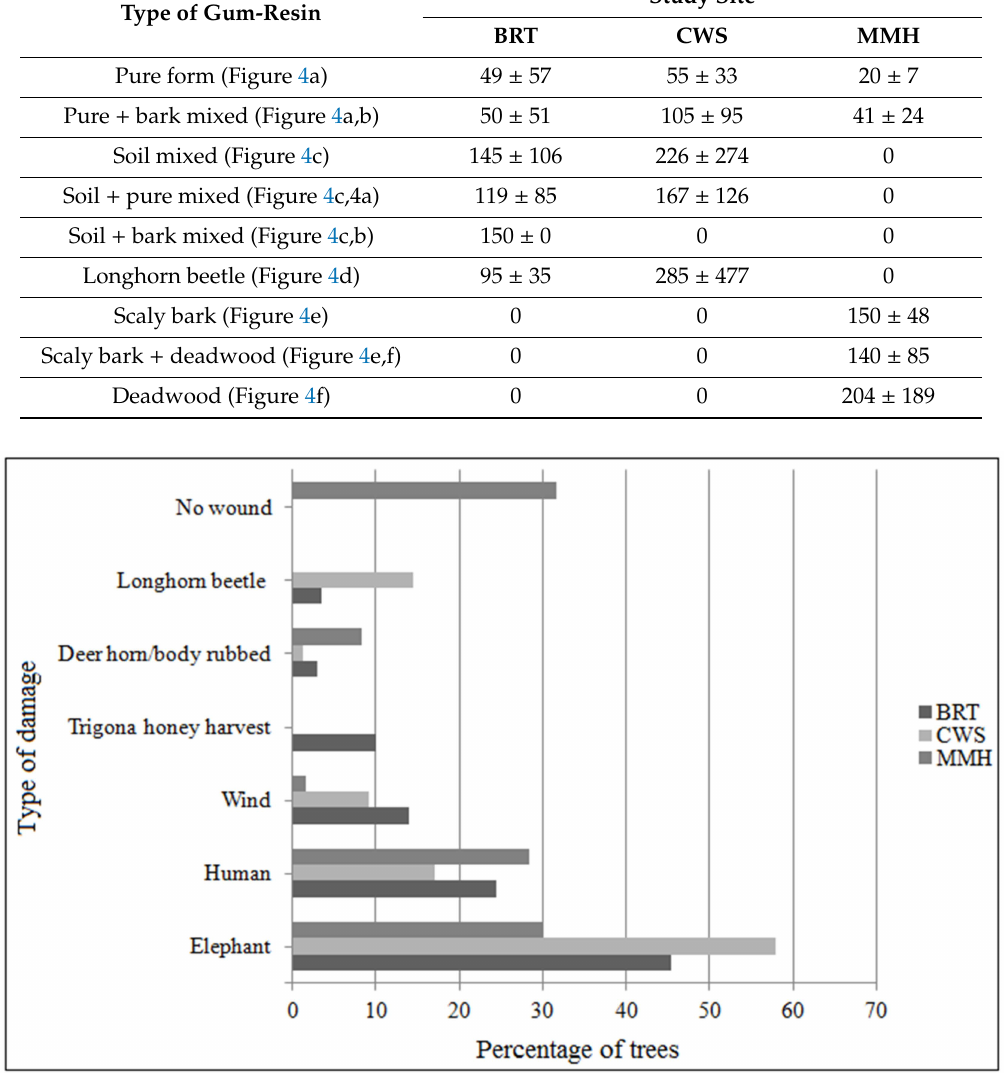
Figure 6. Damage proportions across the study sites observed during harvest trips. Table 3. Average age (according to the harvesters) and dimensions of di ff erent types of damage. Type